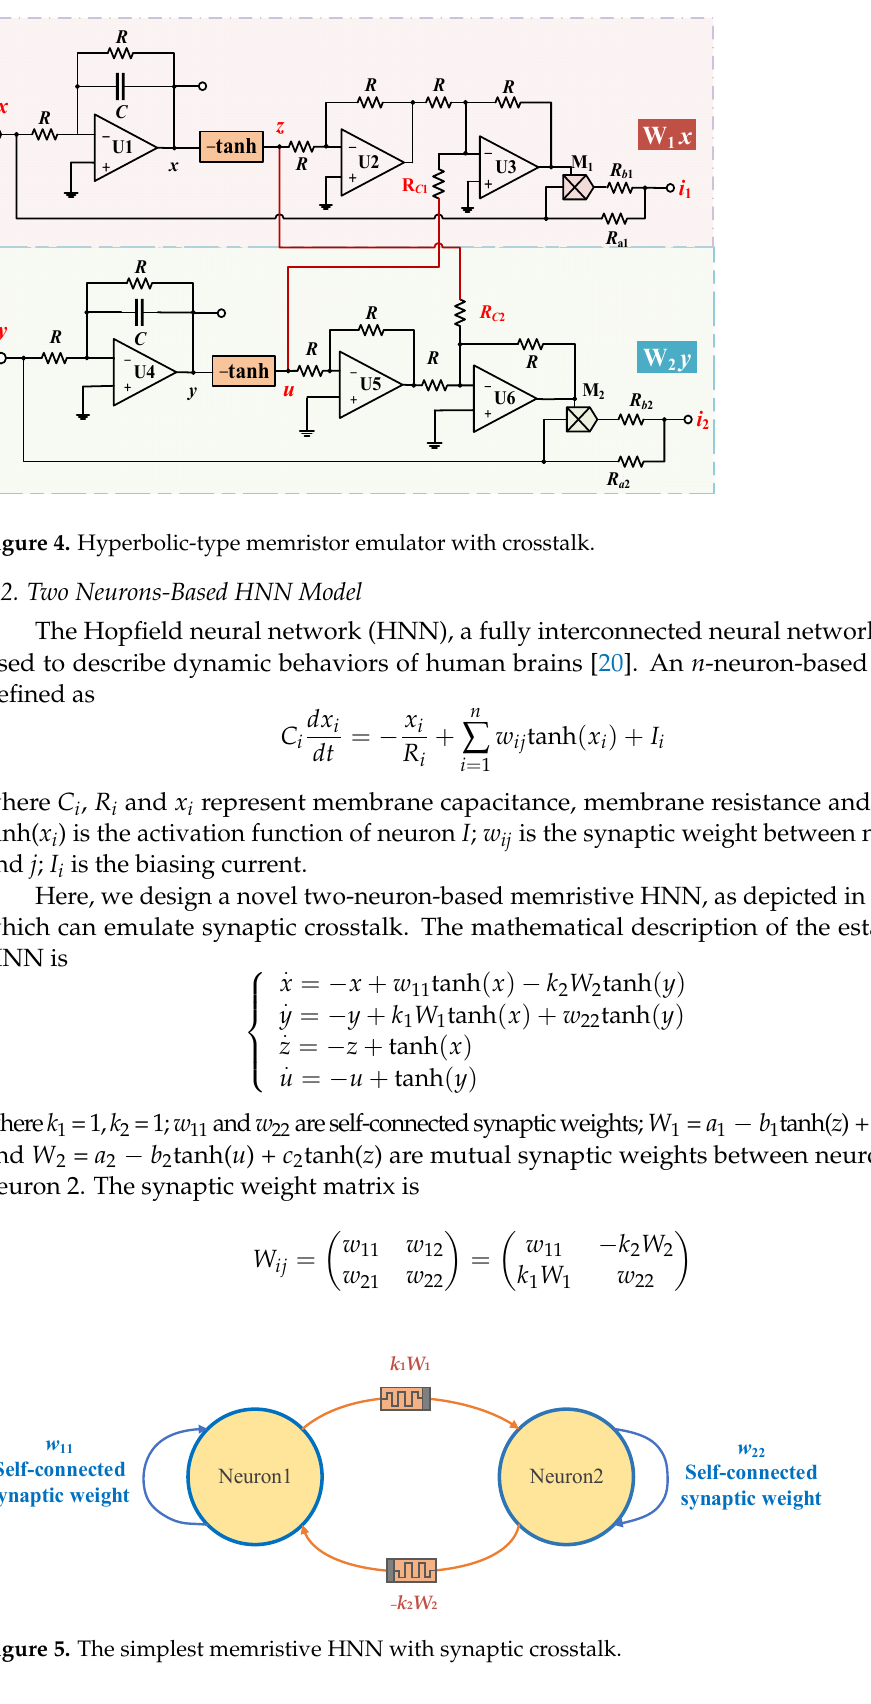
Figure 5. The simplest memristive HNN with synaptic crosstalk.